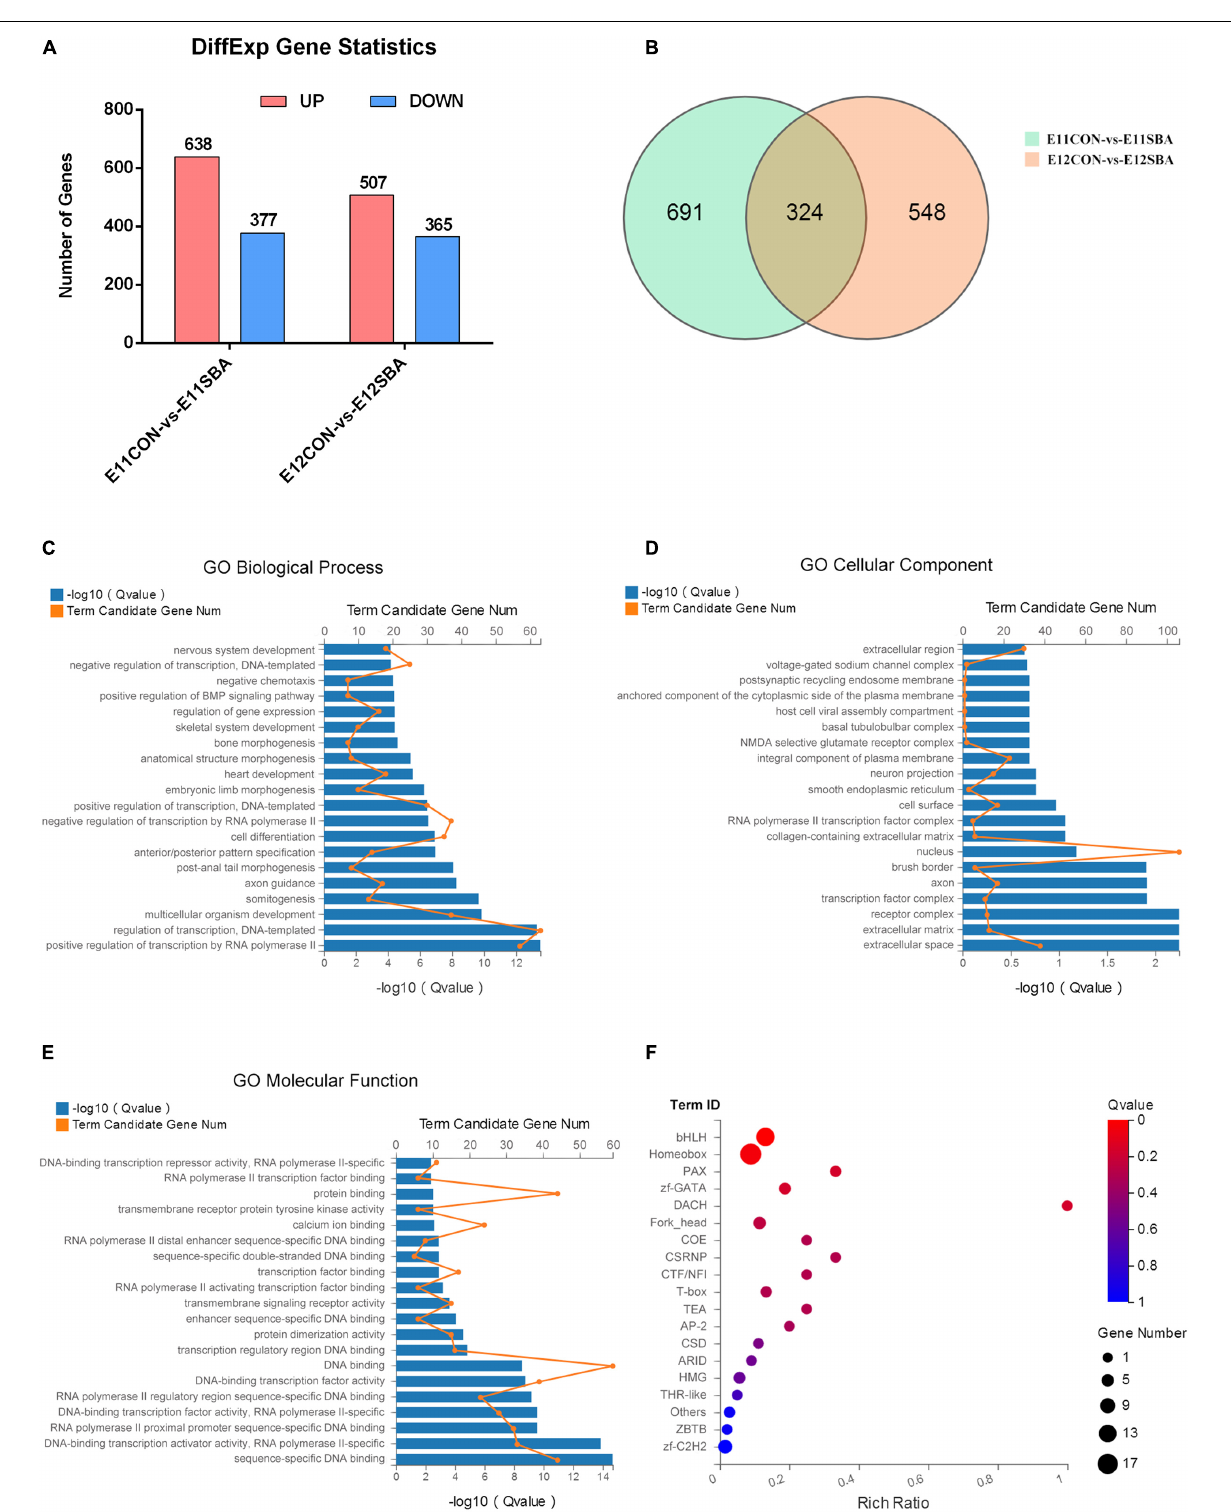
Frontiers in Cell and Developmental Biology |